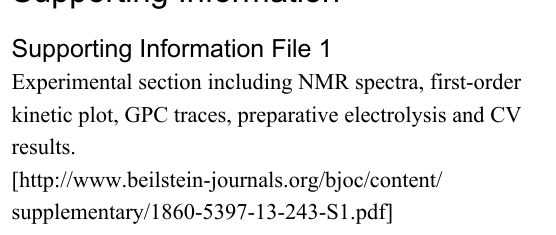
macromolecular stars and brushes with predictable molecular weights of the polymer